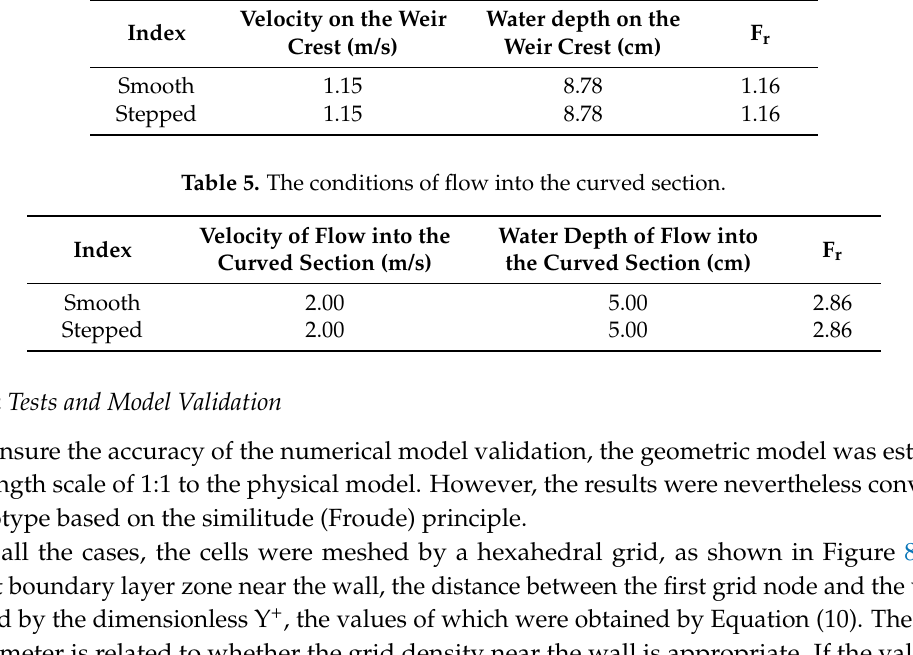
Table 4. The flow conditions of the physical model on the weir crest. F r : Froude number.